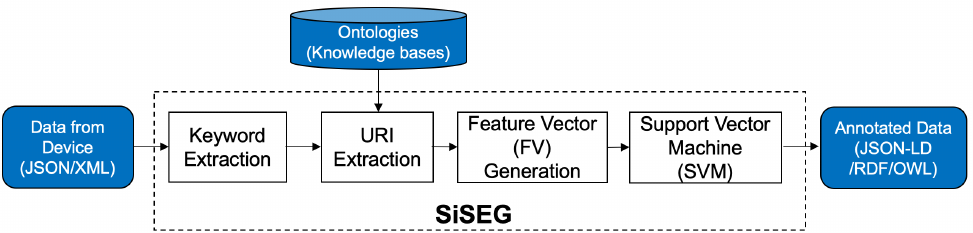
Figure 4. SiSEG functions and process